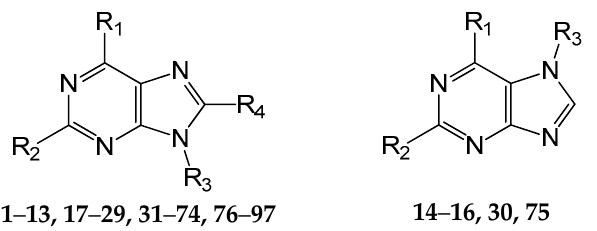
Figure 5. The general structures of all compounds used in this study. Table 5. Chemical structures and experimental activity values (pIC 50 ) of the MGMT inhibitors.